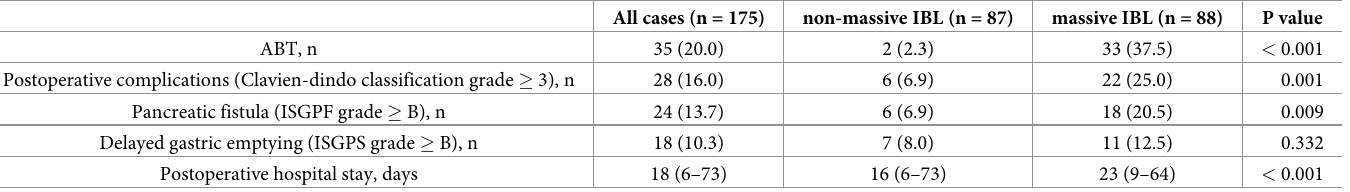
ABT, allogeneic red blood cell transfusion; IBL, intraoperative blood loss; ISGPF, the International Study Group of Pancreatic Fistula; ISGPS, the International Study Group of Pancreatic